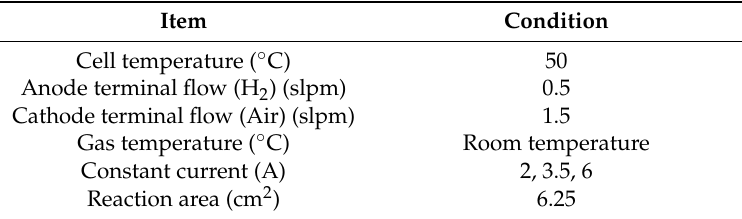
Table 1. Fuel cell test conditions.